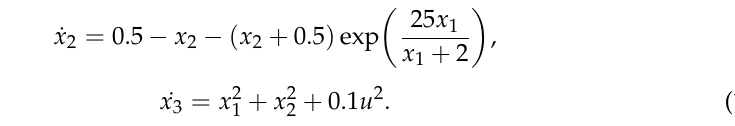
Table 4. The results of the nonlinear stirred tank reactor control problem (20 replications). PARL-MMO Successful Replications Average Budget